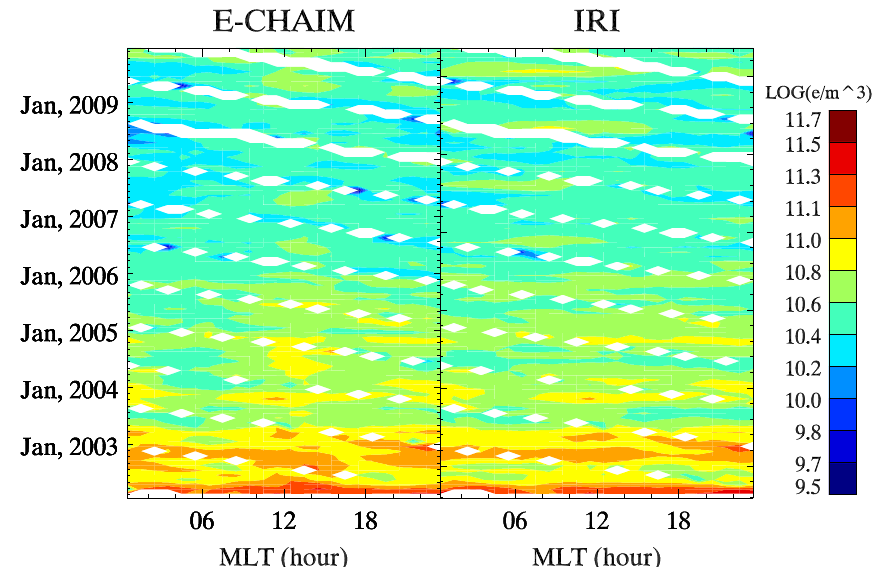
Fig. 18. Log contours of E-CHAIM (left) and IRI (right) monthly RMS electron density errors with respect to CHAMP in situ measurements from a bin between 75 (cid:1) N and 85 (cid:1)